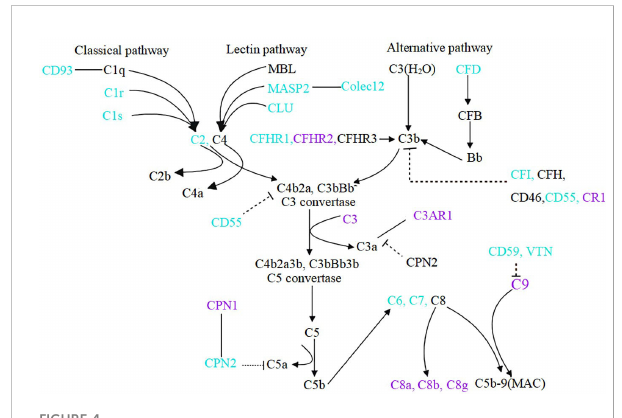
FIGURE 4 Components of complement system change in the urine of IgAN patients. Compared to healthy controls, blue font indicates down- regulation of urinary complement in IgAN patients, purple font indicates up-regulation, and black font indicates complement not detected or no statistically signi fi cant. Dotted lines indicate inhibitory relationships, solid arrows indicate facilitation, and solid lines without arrows indicate protein